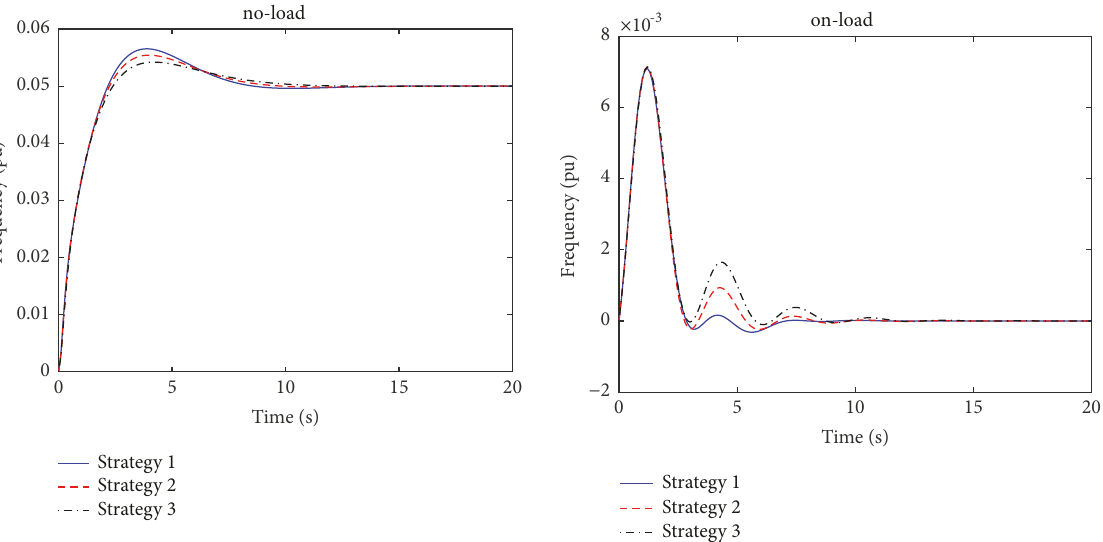
Figure 11: Transient process by different control